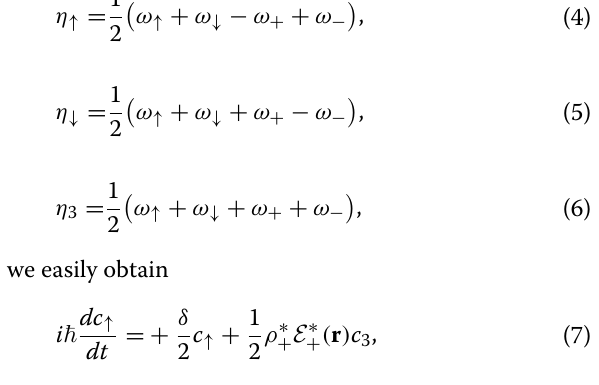
characterizes the dipole interactions between the valence electron and light fields. Here, the valence electron and